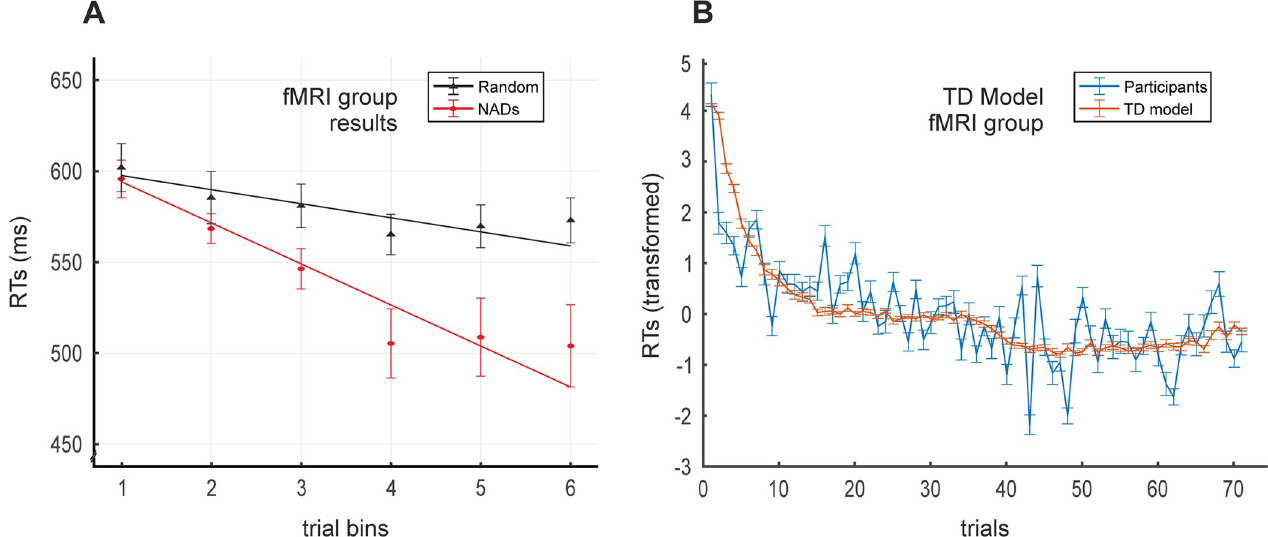
Fig 3. fMRI group’s SL and TD model results. (A) Slopes for NADs and Random blocks ( N = 31) derived from the linear mixed model. A significantly steeper slope for the NADs block (red) compared to the Random block (black) indicates SL over trials. Actual data shown averaged into 6 trial bins with the SEM for display purposes. All data points per participant were used for the linear mixed model analysis. (B) Plot of participants’ mean RTs (blue) against the TD model’s estimates of the development of predictions over learning (red; inverted as 1- P (A) before averaging and z-scoring for display purposes). Vertical bars = SD. RTs were initially transformed (Materials and methods) and are plotted with the inverted model estimates in z-score values. P (A) = TD model’s predictions from the initial word (A) of the dependencies. Data used to generate Fig 3 can be found in S2 Data. fMRI, functional magnetic resonance imaging; NAD, nonadjacent dependency; RT, reaction time; SL, statistical learning; TD, temporal difference.